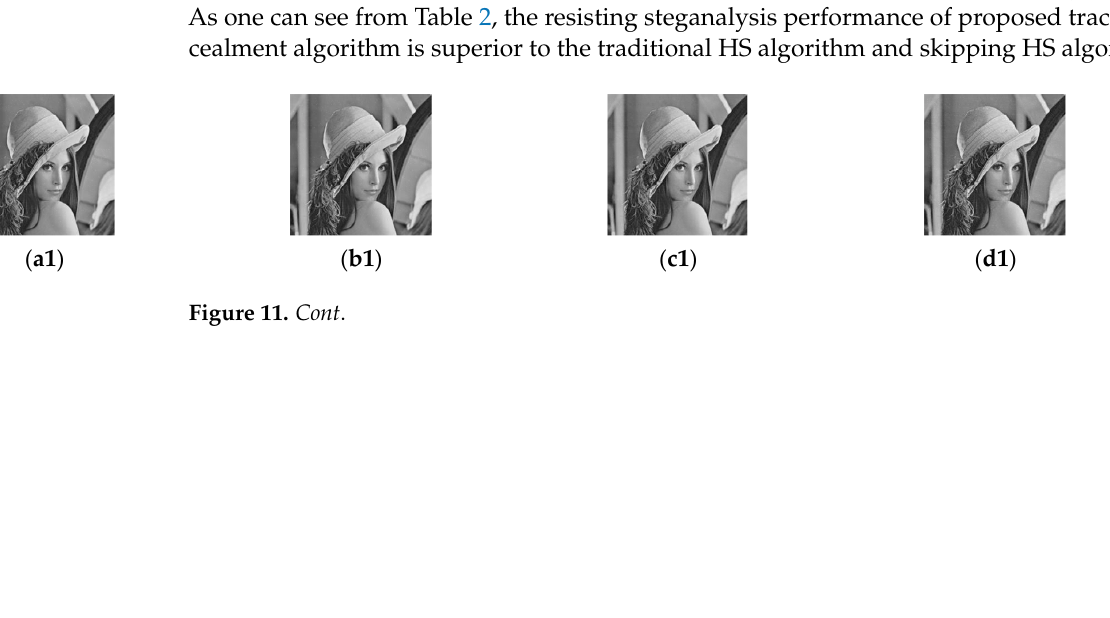
Figure 10. Comparisons between the sparse coding in [13] and the improved sparse coding: ( a ) se- cret data is in image form; ( b ) secret data is generated randomly; and ( c )